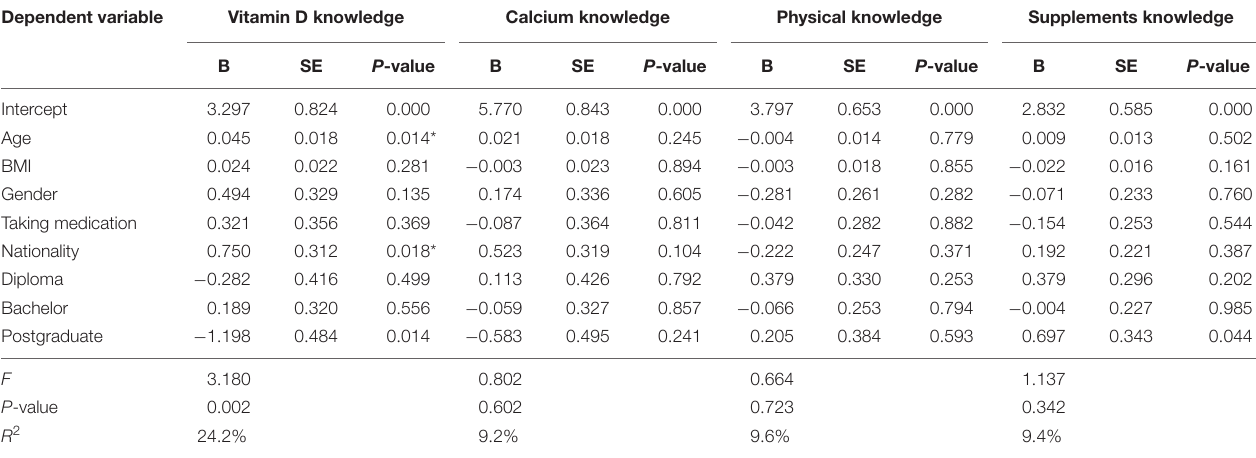
TABLE 5 | Regression analysis for factors affecting knowledge